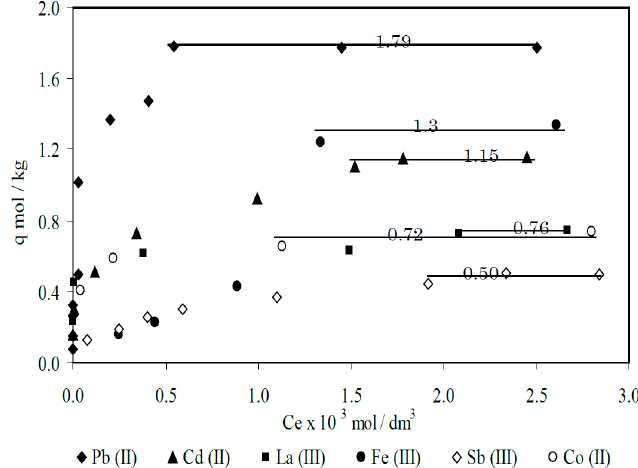
Figure 2. Relationships between the amounts of some metal ions adsorbed from a buffer solution by the crosslinked lignocatechol gel (q) and the equilibrium metal concentrations (Ce), i.e., adsorption isotherms, at 30 °C The Pb(II), Cd(II), La(III), Sb(III), and Co(II) tests were performed at pH = 5.2, and the tests for Fe(III) were performed at pH = 2.5. Dry weight of lignocatechol gel = 20 mg, test solution volume = 15 mL, shaking time = 24 h.